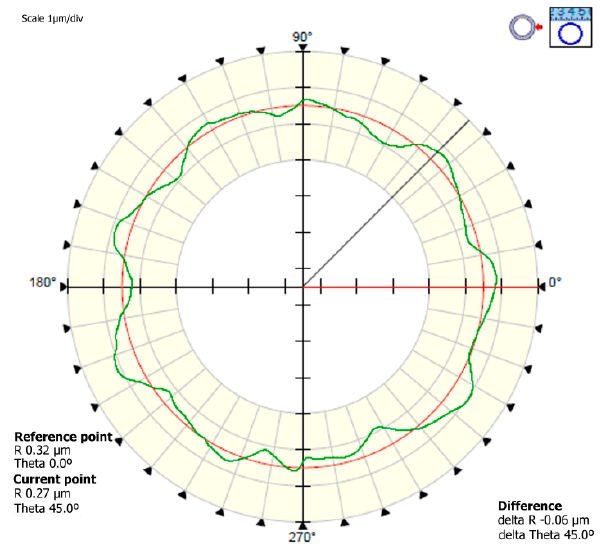
Figure 6. Inner ring raceway diameter shape.